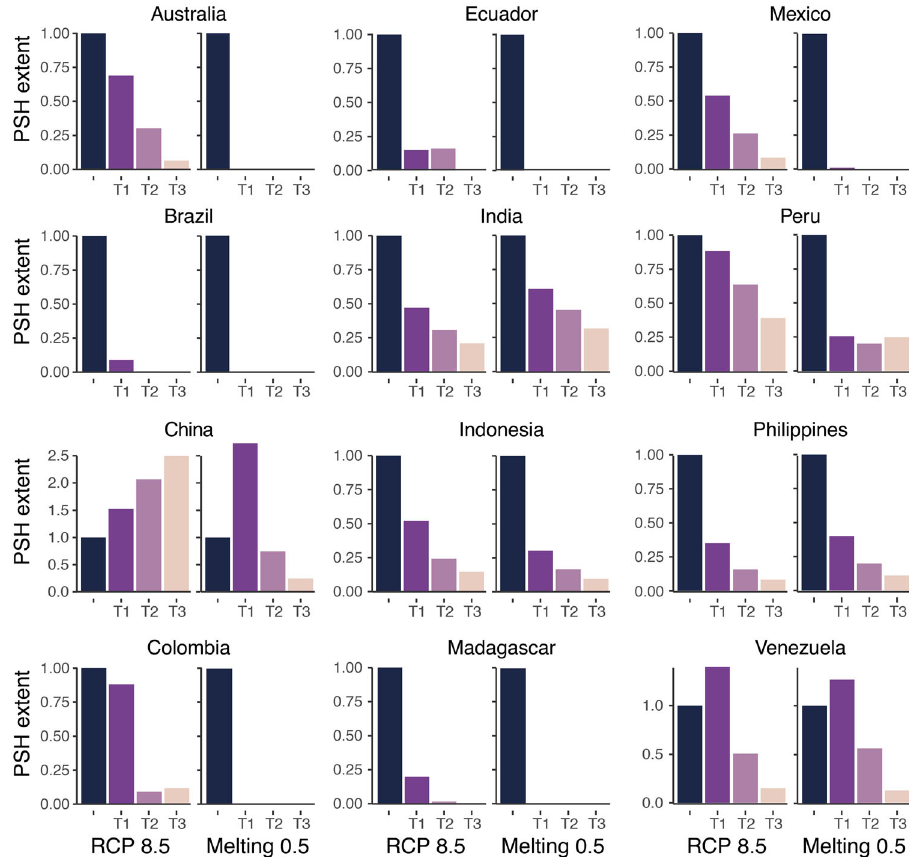
Fig. 7 Temporal changes in the spatial extent of potential species hotspots (PSH) across twelve megadiverse countries. The extent of PSH was measured for each country separately as the number of pixels with a species richness (SR) higher than 0.6 × maximum SR. For each country, the extent of PSH was standardized relative to the present-day extent ( fi rst column), where values greater than one indicate an expansion of PSH and values of zero indicate the complete disappearance of PSH. T1: 2030; T2: 2050; T3: 2070. To fi nd other melting scenarios please see the Supplementary